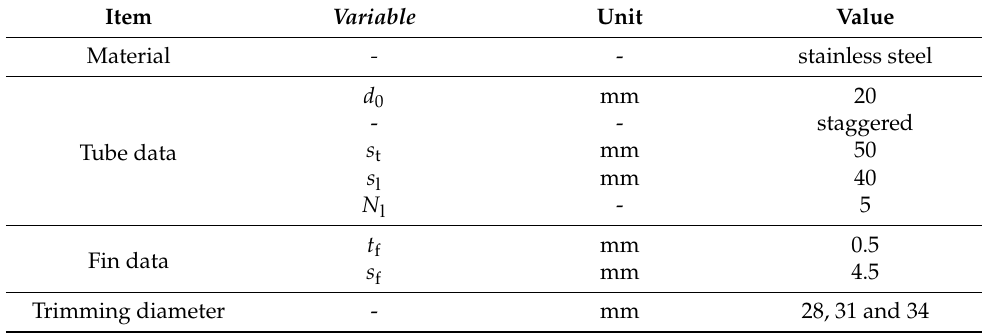
Table 1. Data of the tube and the star-shaped fin.